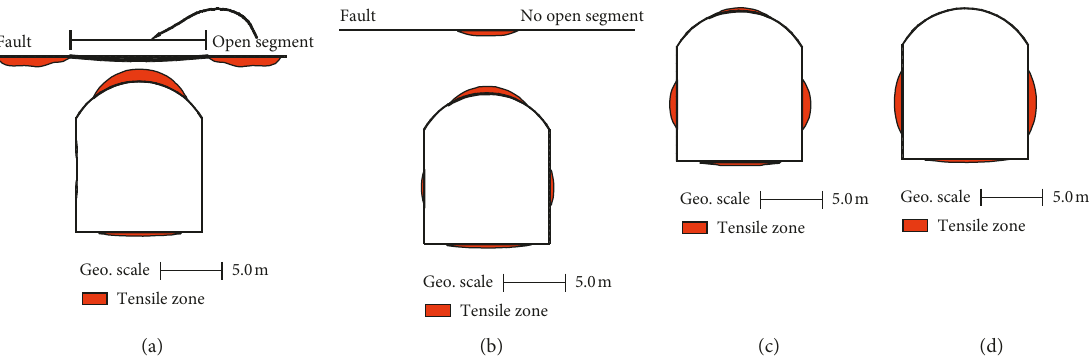
Figure 8: The tensile stress area of the surrounding rock mass: (a) 0.2 spans; (b) 0.5 spans; (c) 1.0 span; (d) no